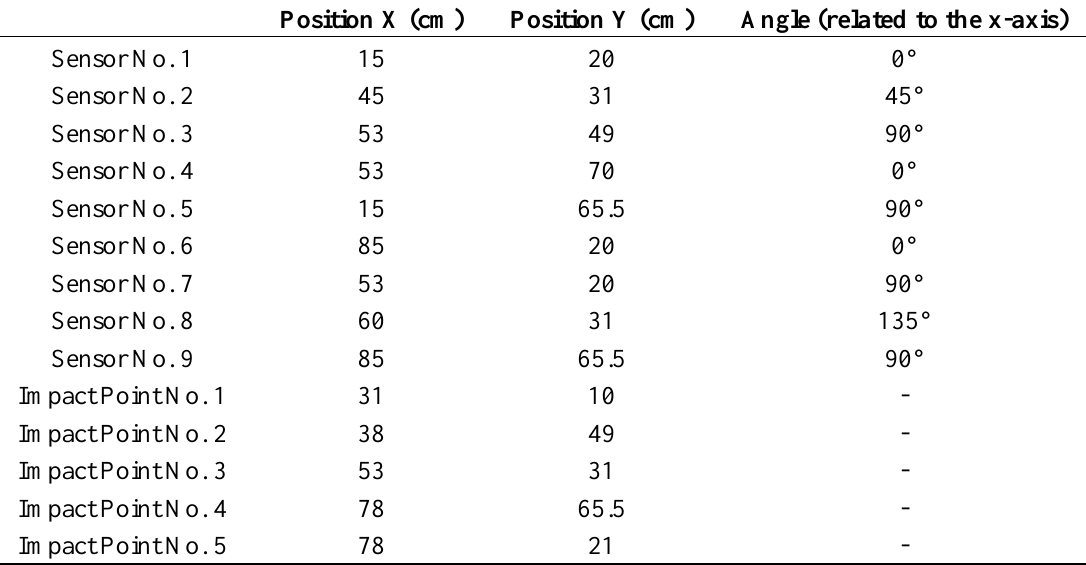
Table 1. Fiber-Bragg-Grating Sensor and Impact